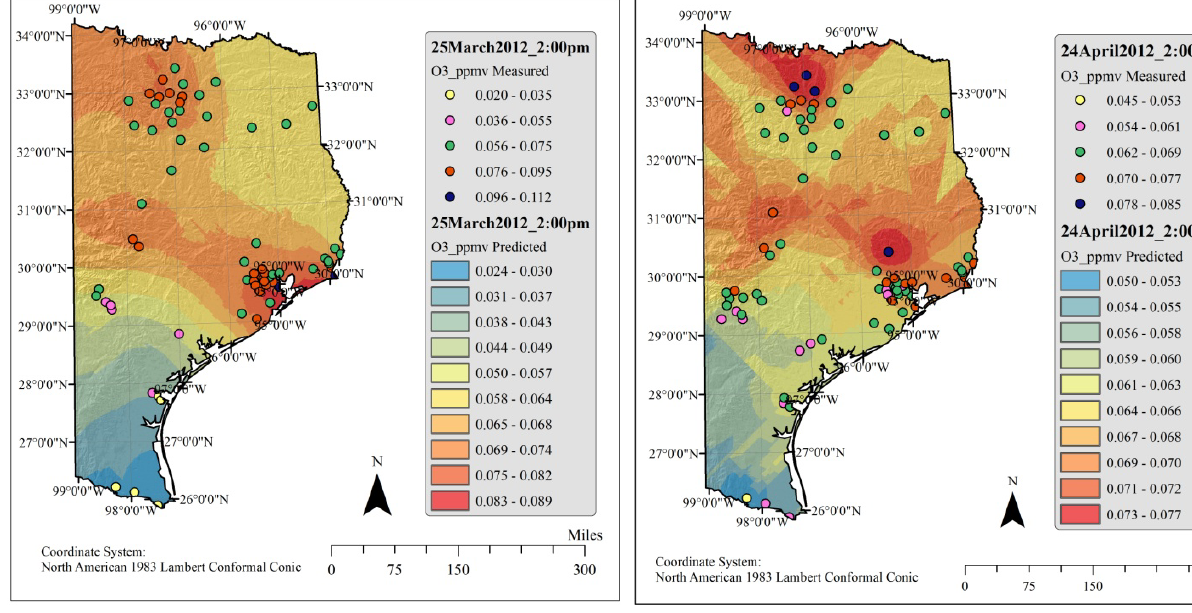
Figure 6. Produced pollution maps of eastern Texas for the studied